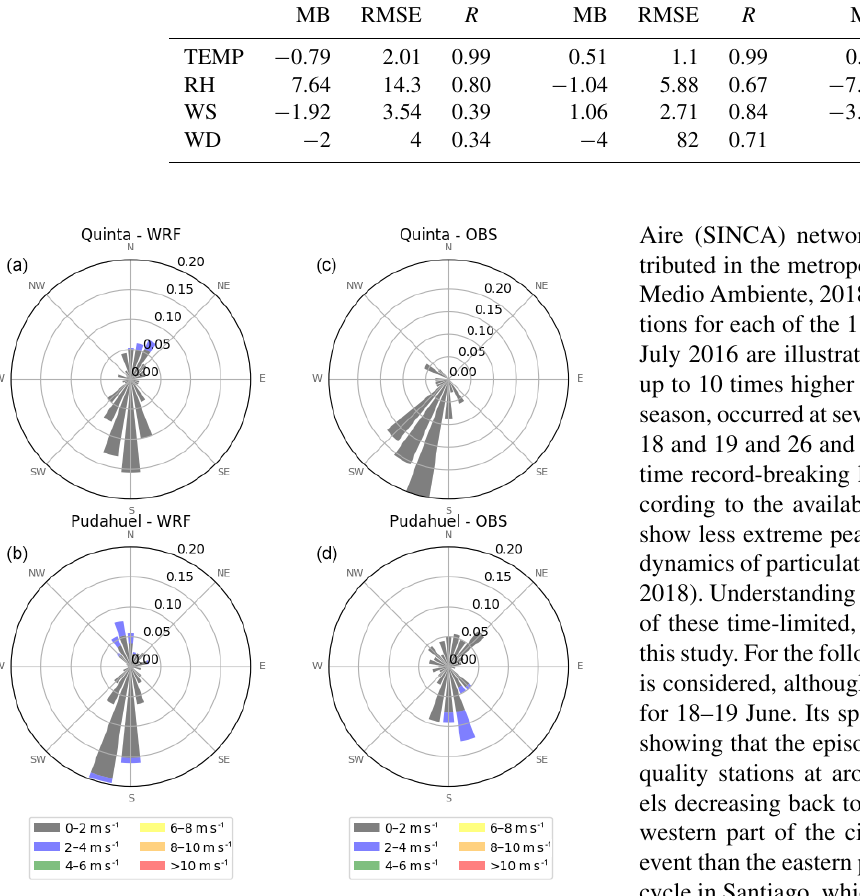
Figure 2. Modeled (a, b) and observed (c, d) wind rose between 15 and 30 June 2016 – synoptic stations Pudahuel and Quinta Nor- mal. Table 4. Simulation scores for low-level PM 2 . 5 concentrations, 28 June to 15 July